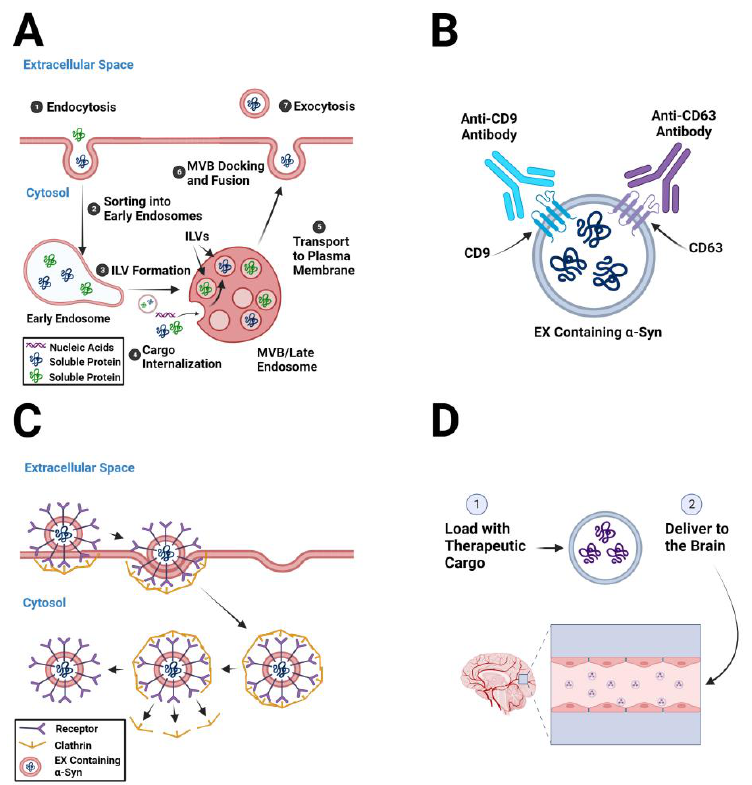
Figure 2. Approaches to minimize or eliminate the pathogenic effects of α -syn-containing EXs in